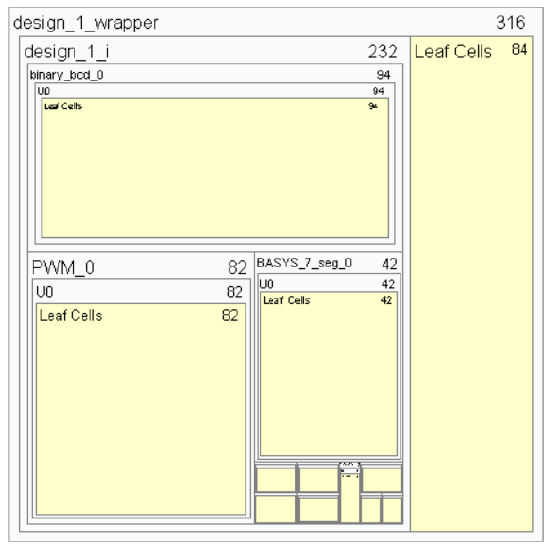
Figure 9. Design hierarchy-trojan-inserted.